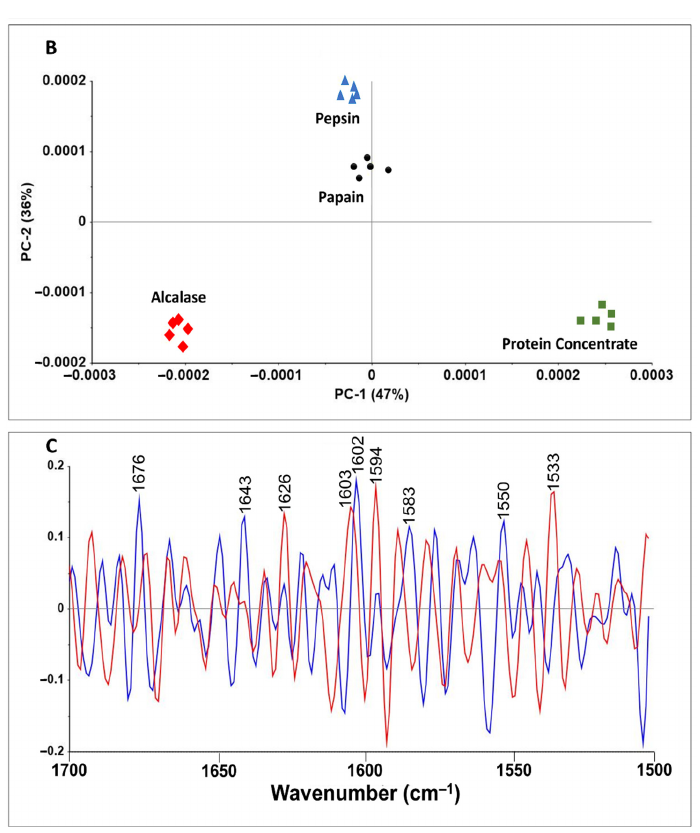
Figure 3. ( A ) Effect of enzymatic hydrolysis on Raman spectra (1700–1500 cm − 1 ) of BSF protein: protein concentrate (blue); Alcalase hydrolysate (black); papain (green), pepsin (red); ( B ) principal component analysis (PCA) model of protein concentrate and protein hydrolysates; ( C ) loading plot of BSF proteins: PC1 (blue), PC2 (red).